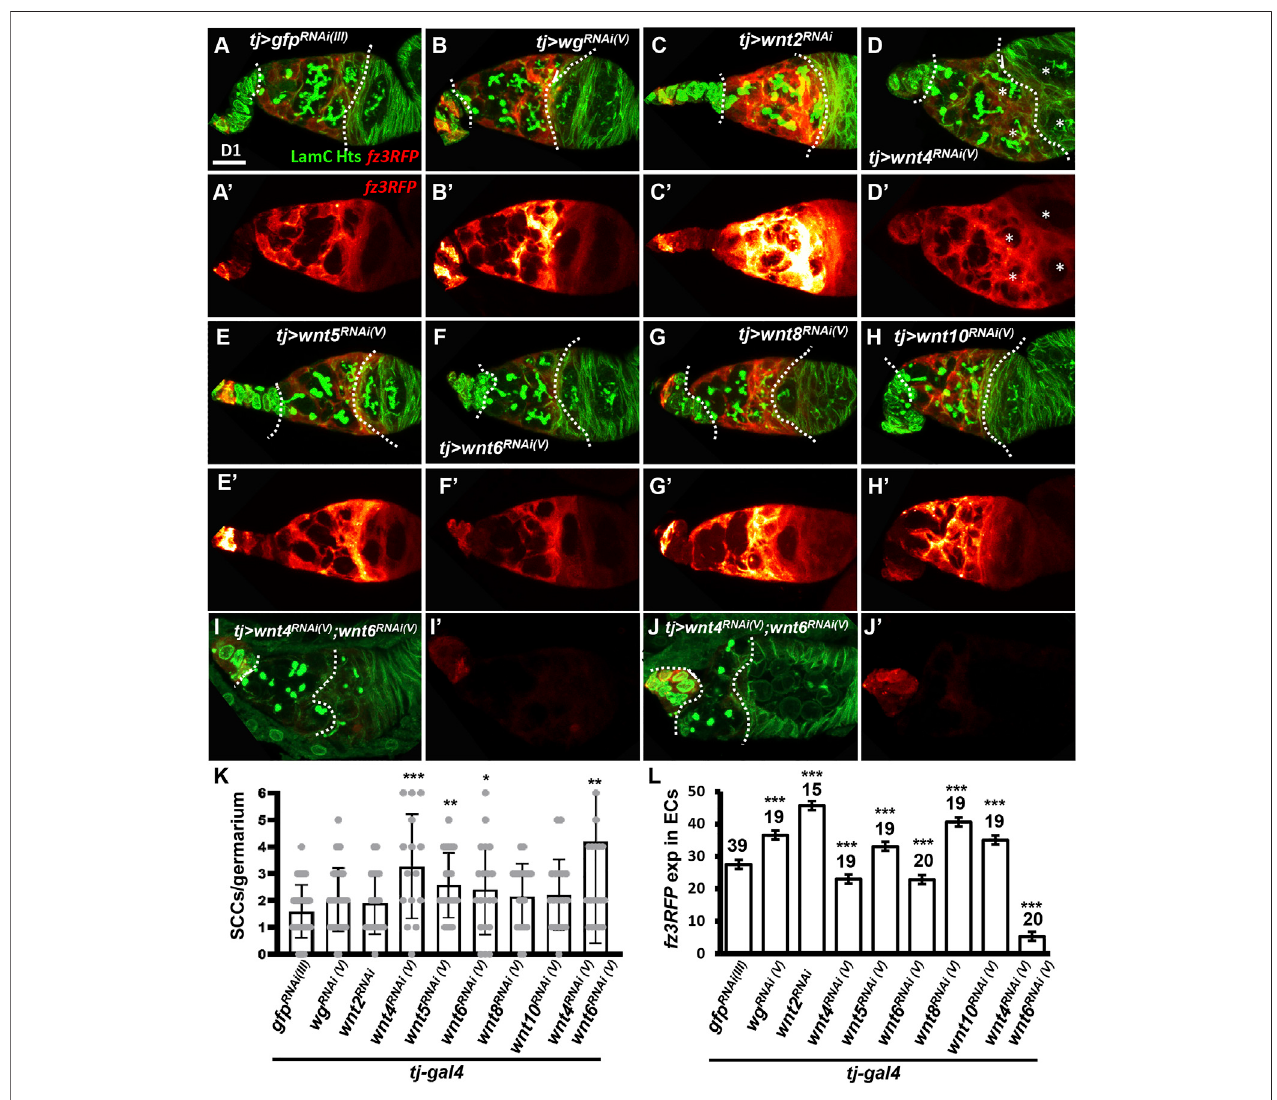
FIGURE 3 | Wnt4 and Wnt6 activate canonical Wnt signaling in escort cells. (A – H) One-day (D) -old tj > gfp RNAi (III) (A) , tj > wg RNAi(V) (B) , tj > wnt2 RNAi (C) , tj > wnt4 RNAi(V) (D) , tj > wnt5 RNAi(V) (E) , tj > wnt6 RNAi(V) (F) , tj > wnt8 RNAi(V) (G) , tj > wnt10 RNAi(V) germaria (H) and tj > wnt4 RNAi(V) &wnt6 RNAi(V) ( (I and J) with fz3RFP (canonical Wntsignaling reporter),LamC (green,terminal fi lamentand cap cell nuclear envelopes), and Hts (green,fusomes). (A ’– J ’ ) ,Heatmapshowing relative intensity, red =low toyellow =high, of fz3RFP inthegermaria. Imageswereprocessed withZen blue andFire look-uptable (LUT); colorgradientbar indicatesstrength of fz3RFP from low (L, red) to High (L, gold). Scale bar, 10 μ m; A – Hhave the same scale bar, K and L have the same scale bar. (K) Number ofspectrosome-containing cells (SCCs) per germarium for indicated genotypes. (L) Expression of fz3RFP in the escort cell region (between cap cells and follicle cells; marked by dashed lines) of germaria with the indicatedgenotypes. RNAi wasexpressedthroughoutdevelopmentuntildissection.Errorbar,mean±SD.Statisticalanalysis,One-wayANOVA,*, p < 0.05;**, p < 0.01; ***, p <